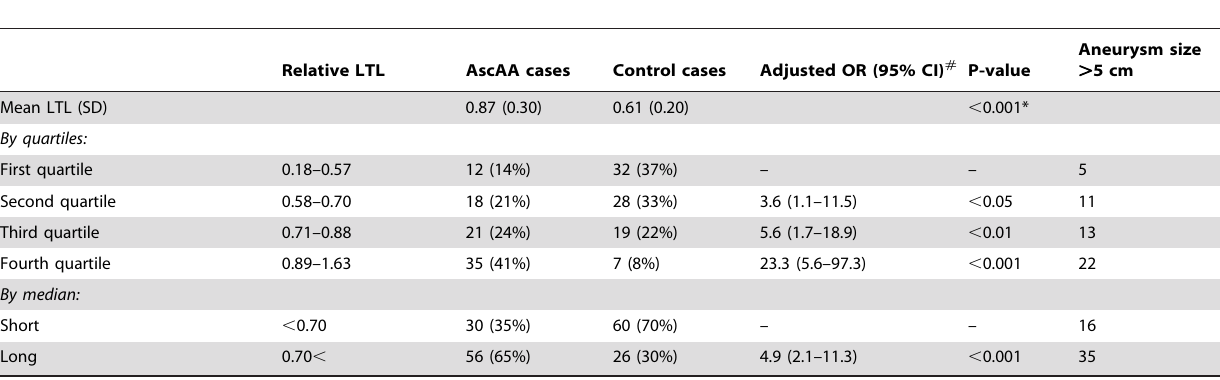
Table 2. Relative leukocyte telomere lengths in AscAA patients and healthy controls. Risks for aneurysms are estimated based on controls.